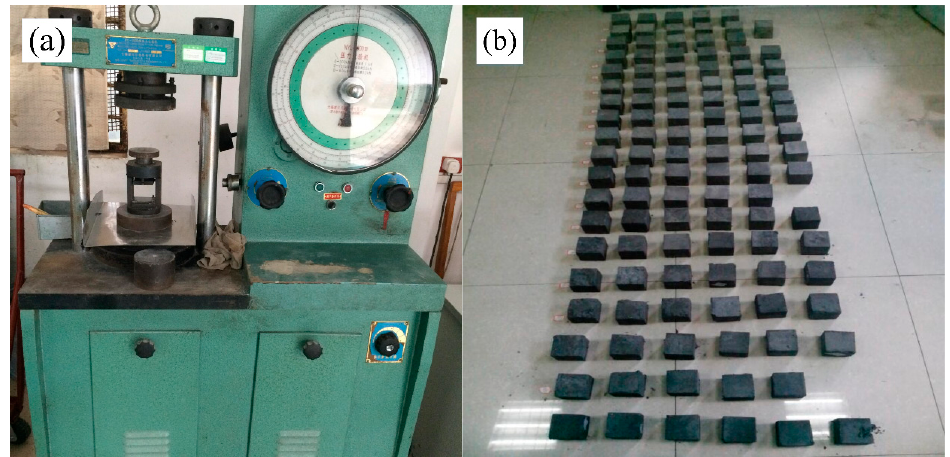
Figure 2. Pressure testing machine and test block: ( a ) pressure testing machine and ( b ) test block.